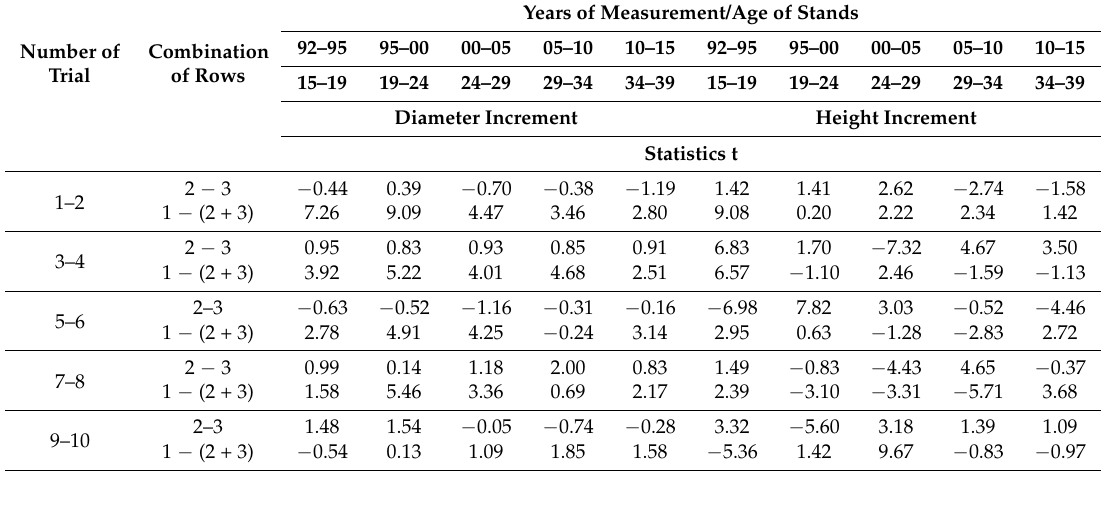
Table 3. Statistical significance of growth difference between trees, growing in different rows.